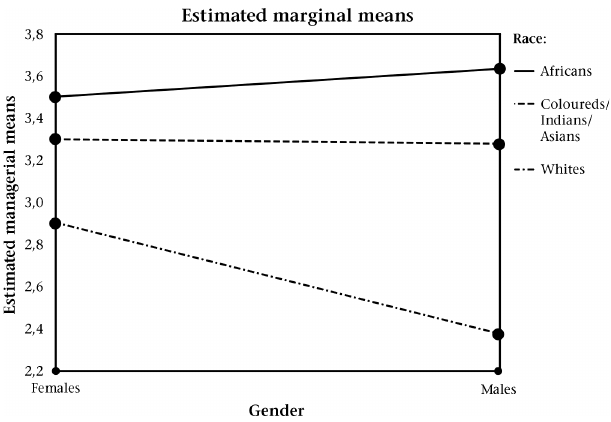
Figure 10: Biographical variables: Age × Home language as predictors of the perceptions of black